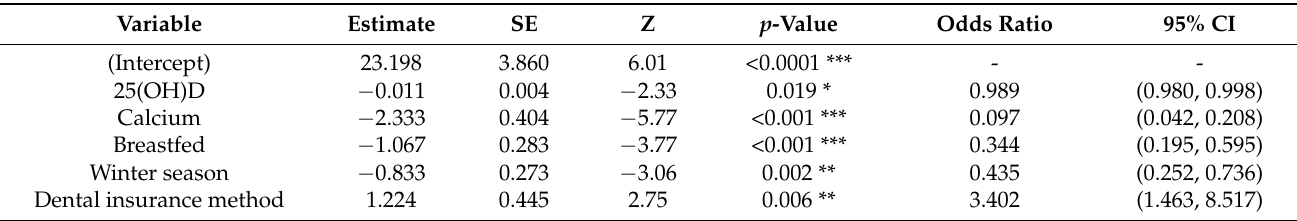
Table 2. Summary of logistic regression model for